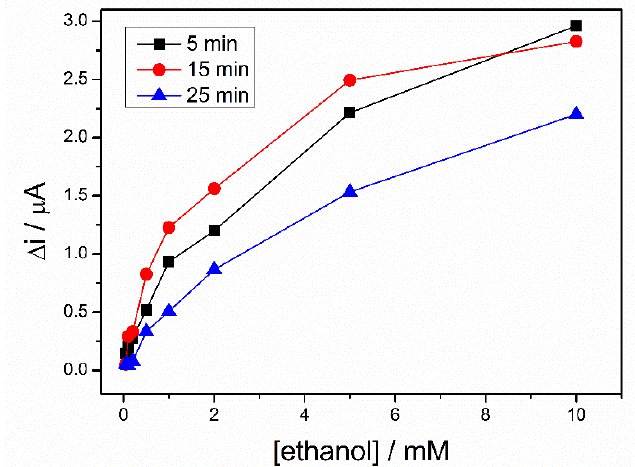
Figure 5. Calibration graph of ADH-sol-gel/PAH/SPE biosensors at different storage time in buffer solution, 5 min (black line), 15 min (red line), 25 min (blue line), (E = +500 mV, [NAD + ] = 10 mM, PBS 0.1 M pH = 8.8).